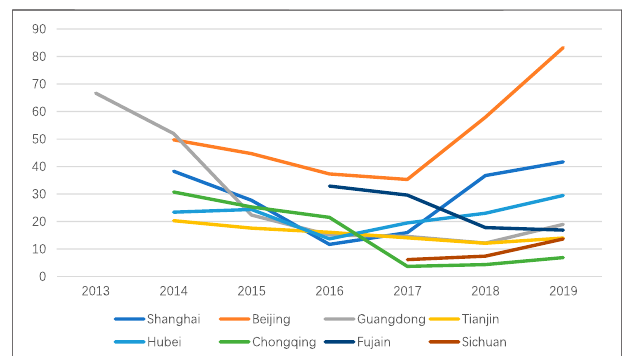
FIGURE 6 | Average annual carbon price of pilot areas.